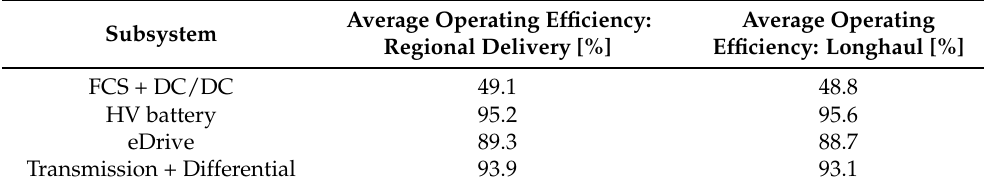
Table 4. Average operating efficiencies of various powertrain components from simulation of the 40-tonne fuel cell truck use case running on VECTO Regional delivery and Longhaul cycles.